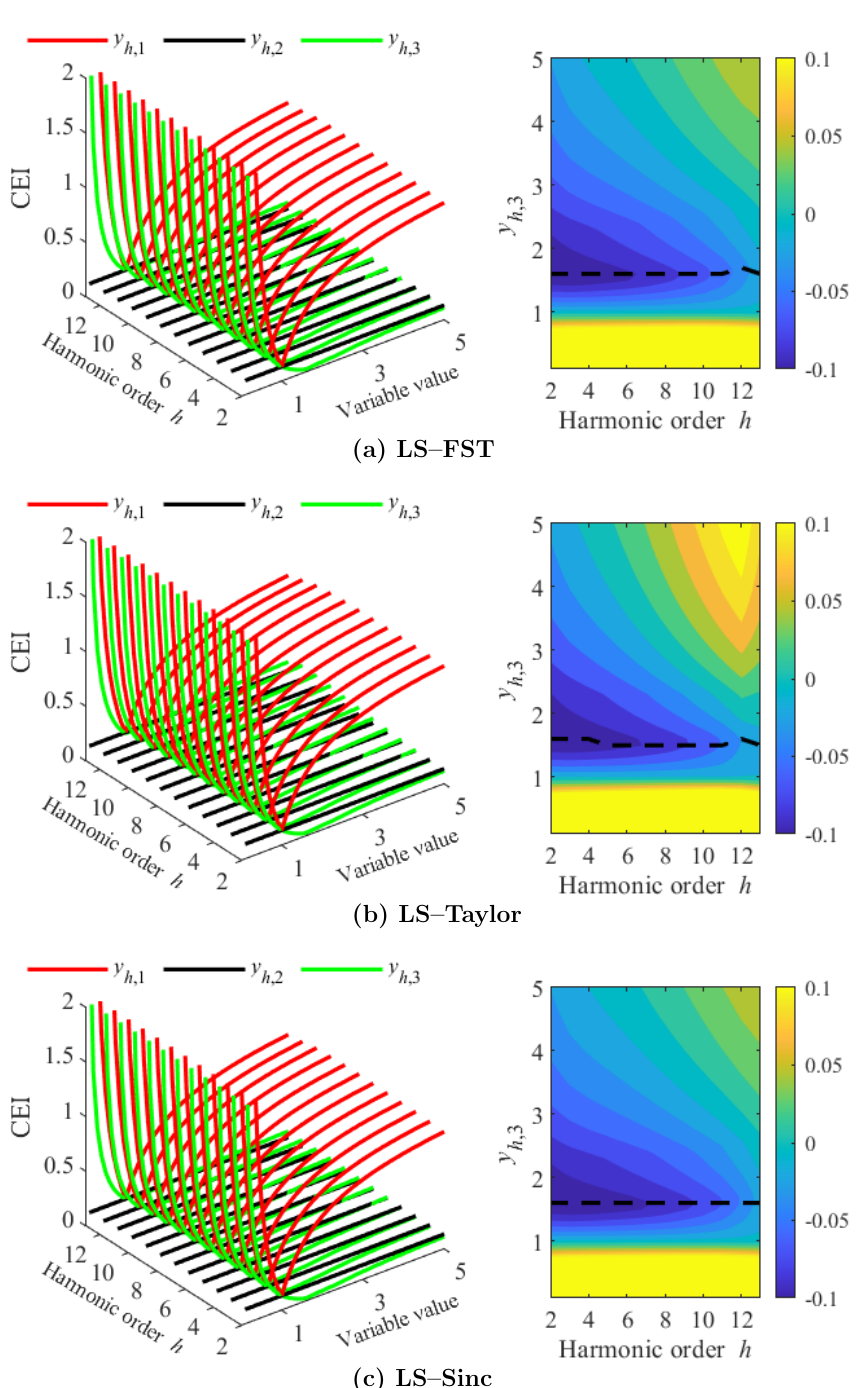
Figure 1. The left subplots show the relationships between CEI and the introduced variables for dif- ferent least-square algorithms. The right subplots show the CEI change when y h ,3 varies. The values with y h ,3 = 1 are used as reference. The black dash line in each subplot represents the optimal value for y h ,3